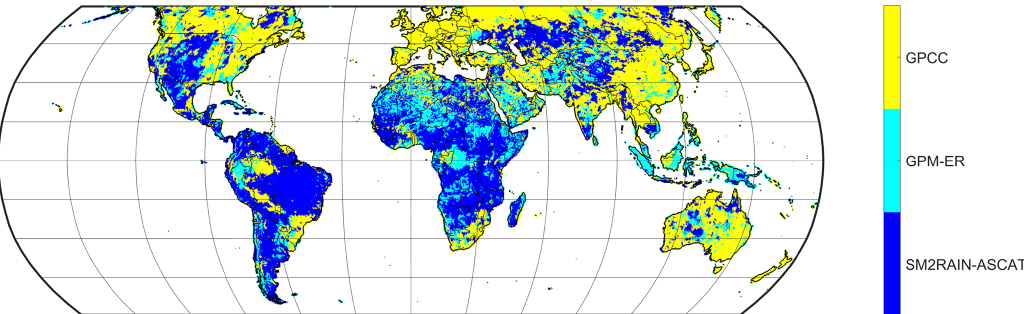
Figure 8. Best-performing product based on the results of the triple-collocation data shown in Fig. 7. SM2RAIN–ASCAT is performing the best among the three products in Africa, South America, the central western United States, and central Asia, while GPCC is performing the best in the remaining parts of the Northern Hemisphere and in Australia. GPM-ER is the best product in tropical and equatorial